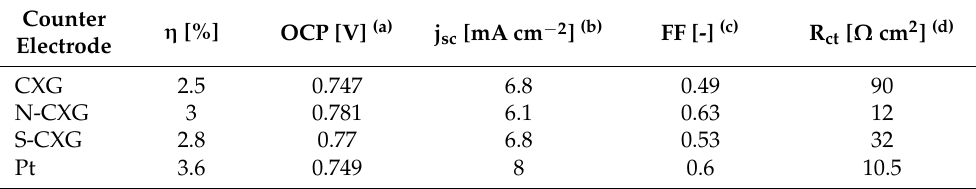
Table 3. Performance parameters of DSSC with CXG as counter